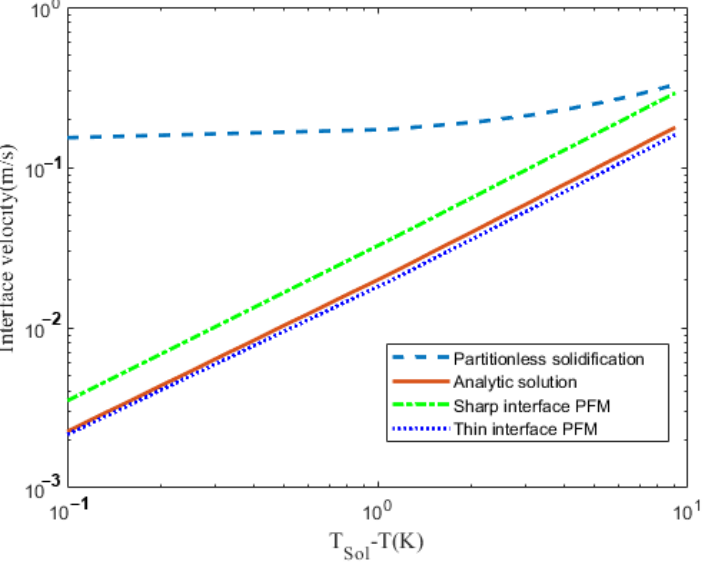
Figure 4. Variation of interface velocity, calculated at 𝜉 ∗ → ∞ as a function of 𝑇 𝑆𝑜𝑙 − 𝑇.